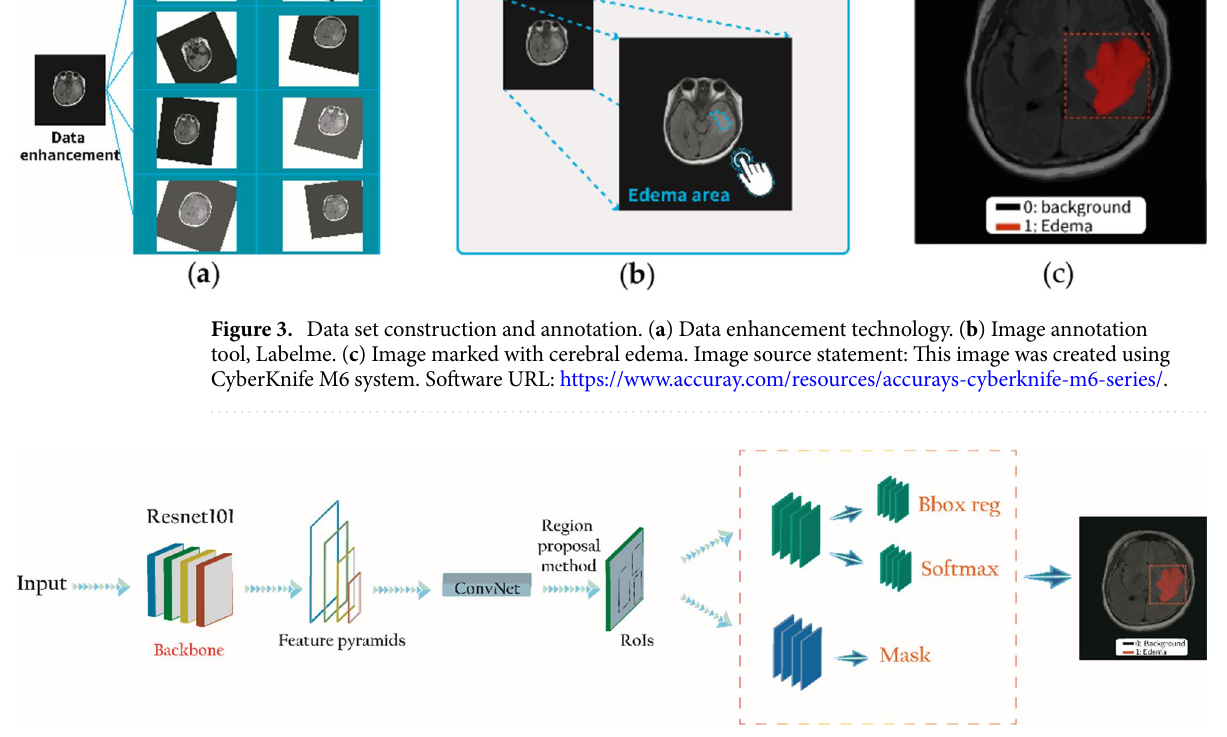
Figure 4. Mask R-CNN network architecture diagram. RoI generate a region of interest. Image source statement: this image was created using Microsoft PowerPoint 2016. Software URL: https:// www. office.